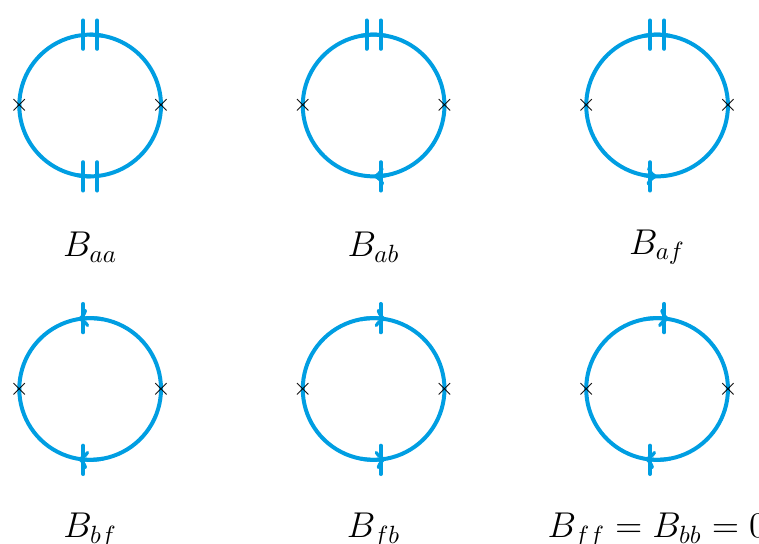
Figure 32. PV one loop B type integrals in the average-di(cid:11)erence